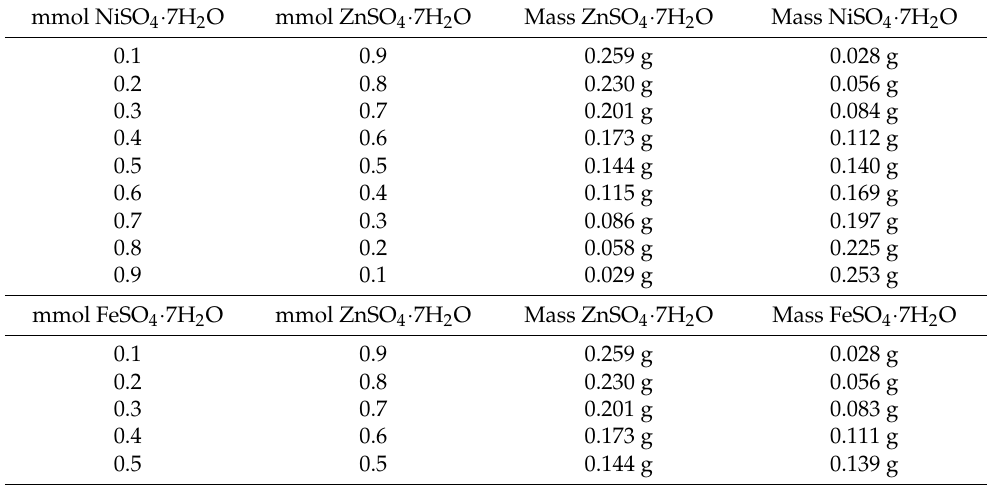
Table 2. Quantities of metal sulfates used in the synthesis of M x Zn (1 − x ) (bpy) 3 ](PF 6 ) 2 molecular